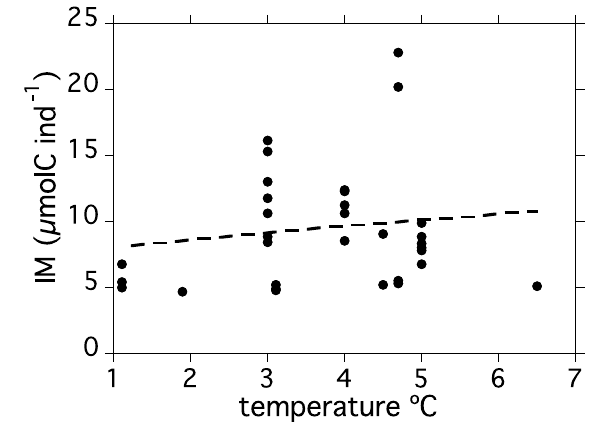
Fig. 2. Relationships between temperature and average ex- perimental IM. The corresponding regression equation was IM=7.4+0.51 T , r 2 = 0 . 021, n =